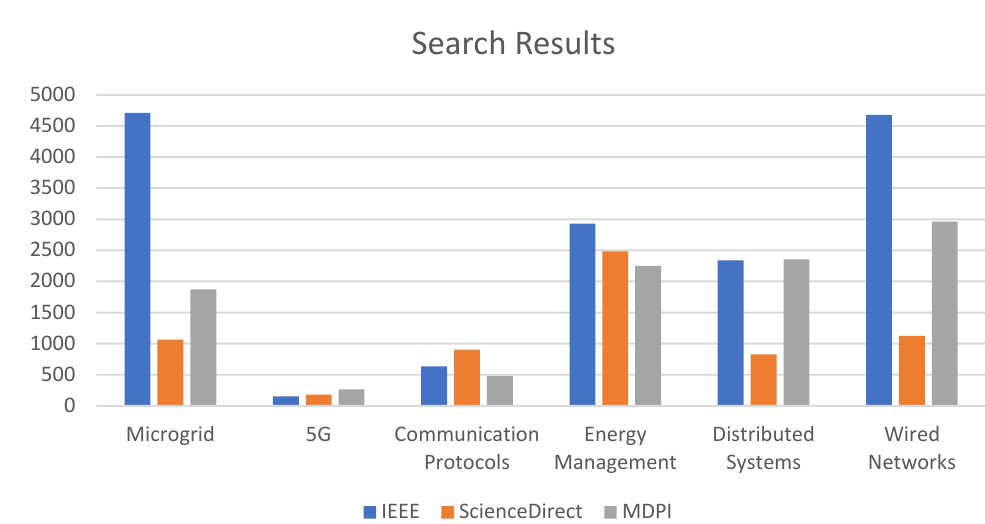
Figure 1. Search results in different sources of information.